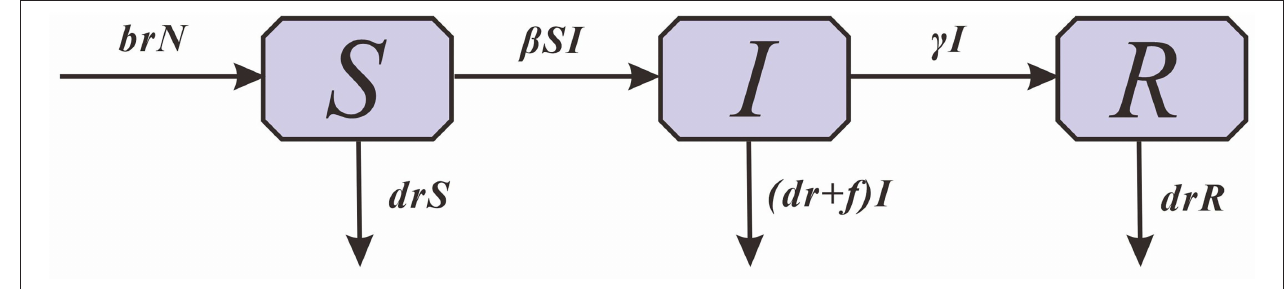
FIGURE 1 | The Susceptive-Infected-Recovered